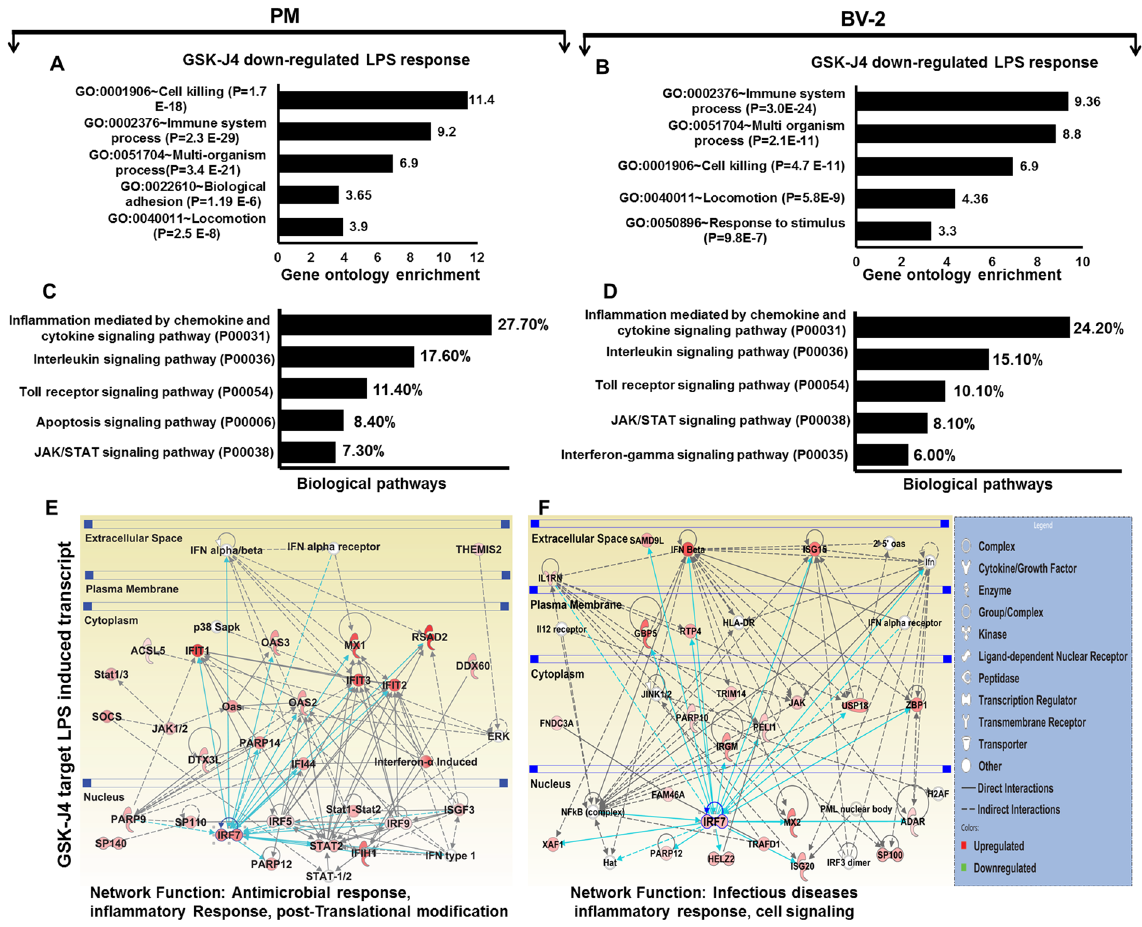
Figure 5. Functional annotation and biological pathways of the GSK-J4 down-regulated genes in PM and BV-2 microglial cells. ( A , B ) GO term enrichment analysis for the “biological process” category of the GSK-J4 down- regulated genes in PM and BV-2 microglial cells. The top GO terms are ranked by the GO enrichment. ( C , D ) The most highly represented biological pathways of the GSK-J4 down-regulated genes in PM ( P ≤ 0.01, and log 2- fold change ≥ 1.5) and BV-2 microglial cells ( P ≤ 0.01, and fold change ≥ 1.5). ( E , F ) Ingenuity ® Bioinformatics pathway analysis of gene networks displaying interactions between infectious diseases, antimicrobial and inflammatory response-related genes that were down-regulated by GSK-J4 at 4-h after LPS stimulation. Genes in white circles were not in our DEG dataset but were inserted by IPA because these genes are connected to this network. The activity of molecules highly connected to this network, namely IRF7, STAT1 and STAT2 (hubs), was assessed using the IPA molecule activity